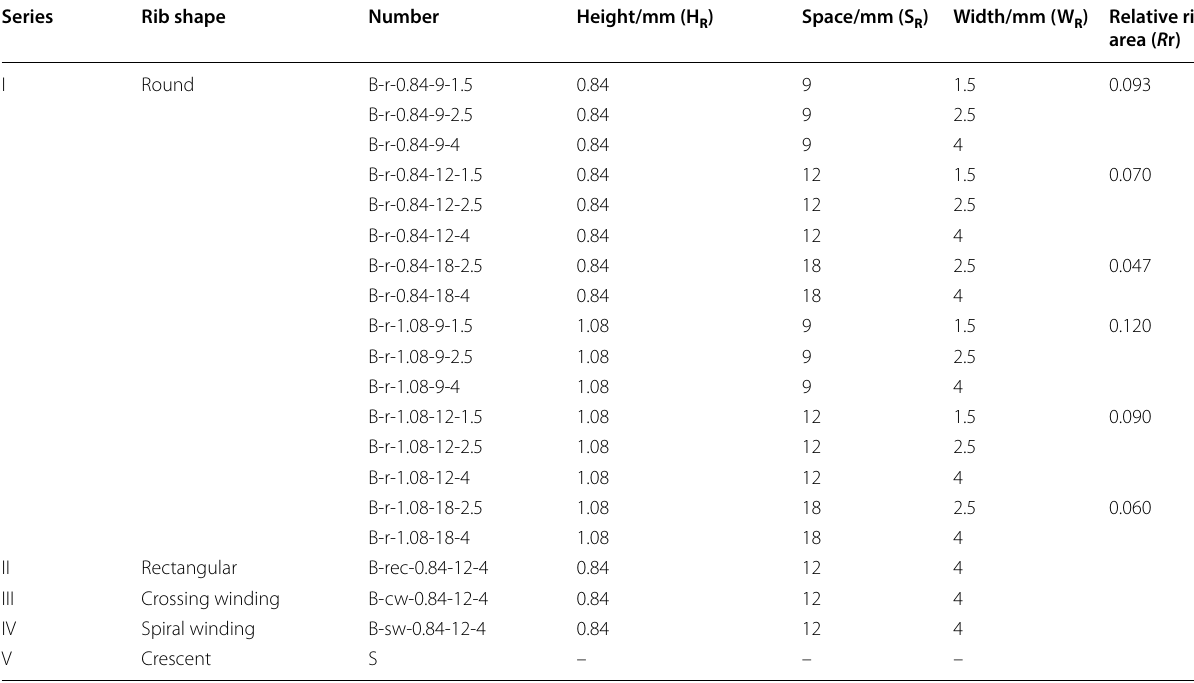
Table 2 Parameters of